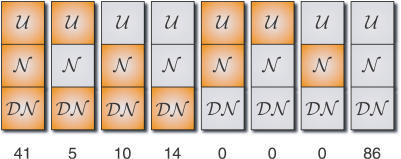
Performance of the Three Positional PriorsA dark orange (light grey) square in each column indicates the situation where the respective prior succeeds (fails) in finding the true motif. There are 23 = 8 possible combinations of successes or failures for the three priors. These are represented by the eight columns, which are ordered based on the success or failure of PRIORITY-D℘N℘. The number of sequence-sets (out of the total 156 sequence-sets) falling into each category is indicated below the respective column.